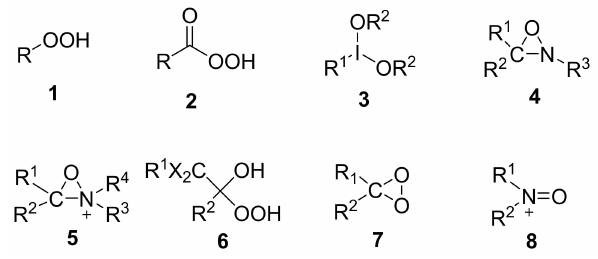
Figure 1. Representative nonmetal organic oxidants.